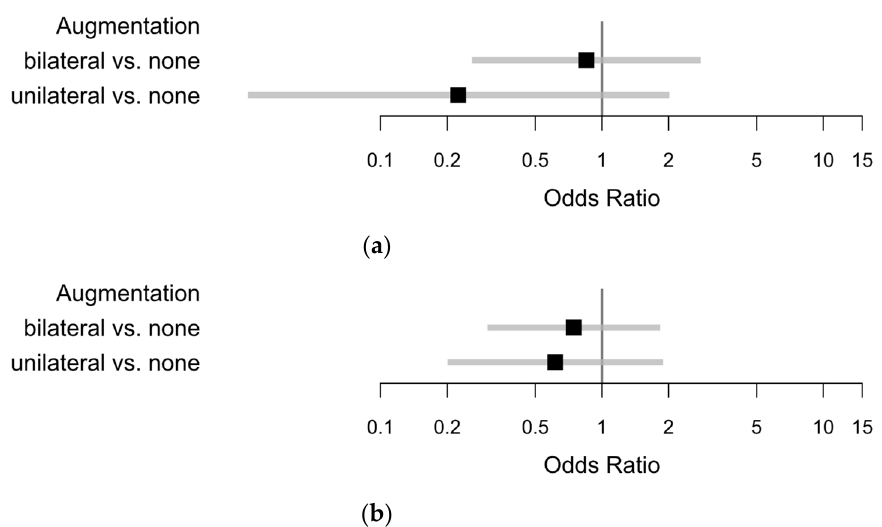
Figure 6. Univariable analysis of augmentation concerning ( a ) major complications; and ( b ) minor